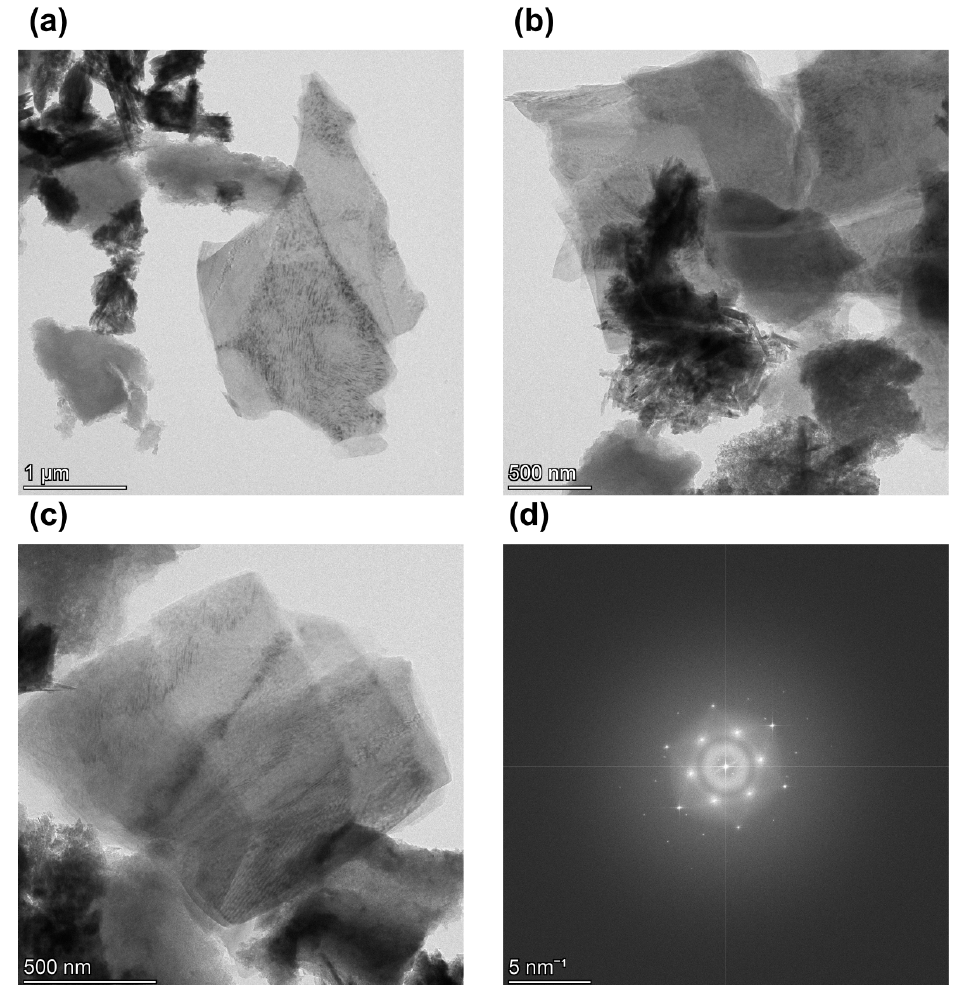
Figure 6. TEM images of sonicated shungite sample at ( a ) at × 13,500 magnification and ( b ) at × 35,000 magnification, ( c ) at × 22,000 magnification, and ( d ) fast Fourier